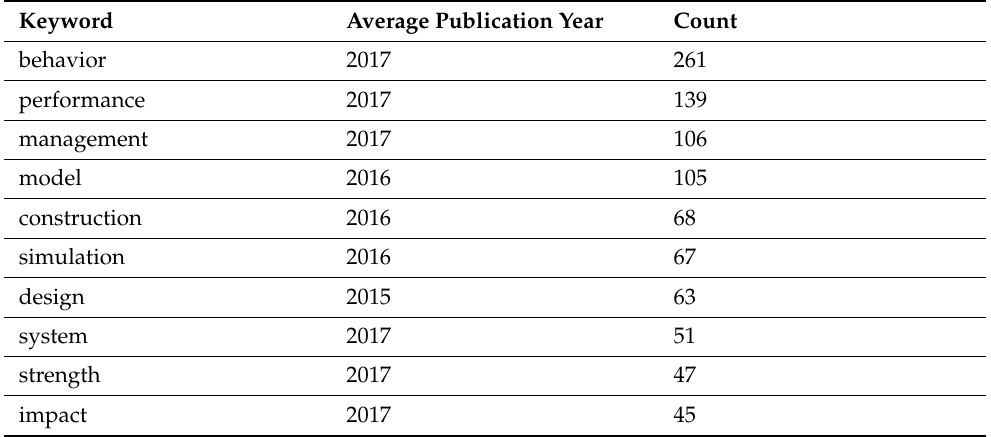
Table 3. Keywords and timing progress